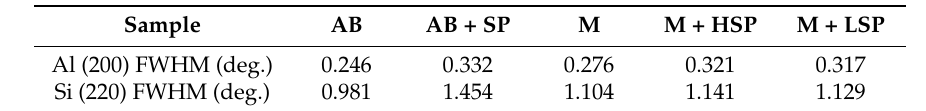
Table 4. The average full width at the half maximum (FWHM) of Al and Si peaks of the as-built, rough-machined, and SP samples.